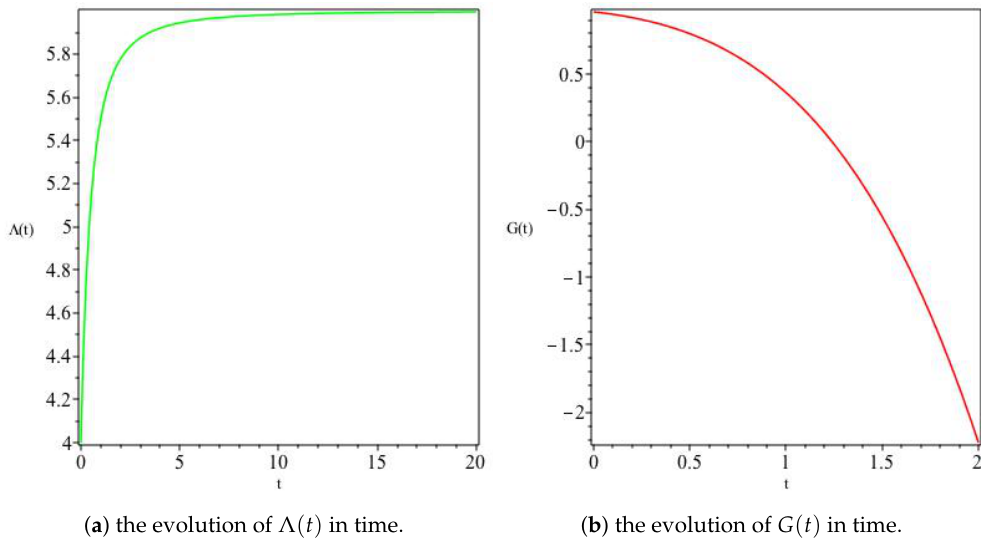
Figure 1. The variation of Λ and G for α = − 2 , β = 2 . In ( a ), we see that an initially increasing Λ asymptotically reaches a constant value at late times, whereas ( b ) shows an initially positive G decreases with time, attaining negative values at alate